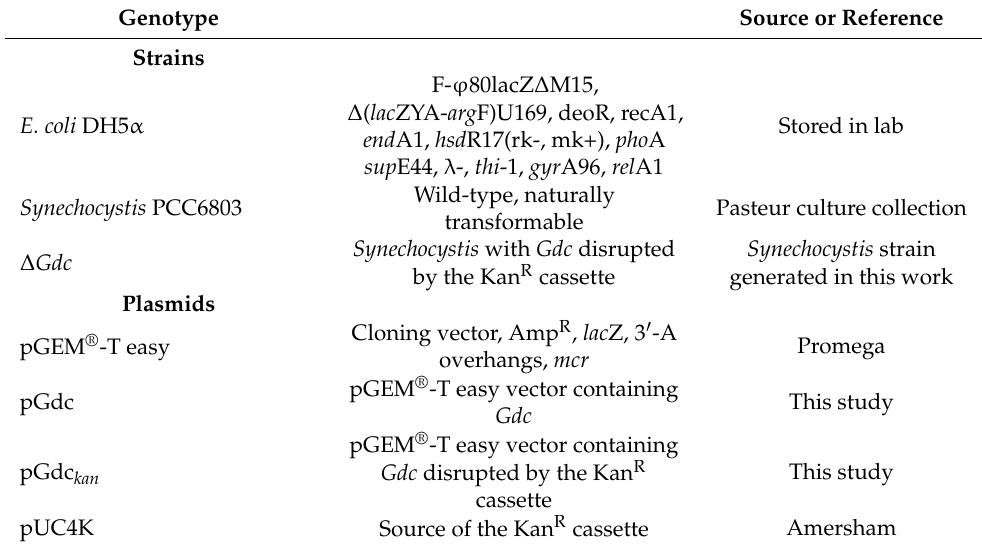
Table 3. Strains and plasmids used in this study. Genotype Source or